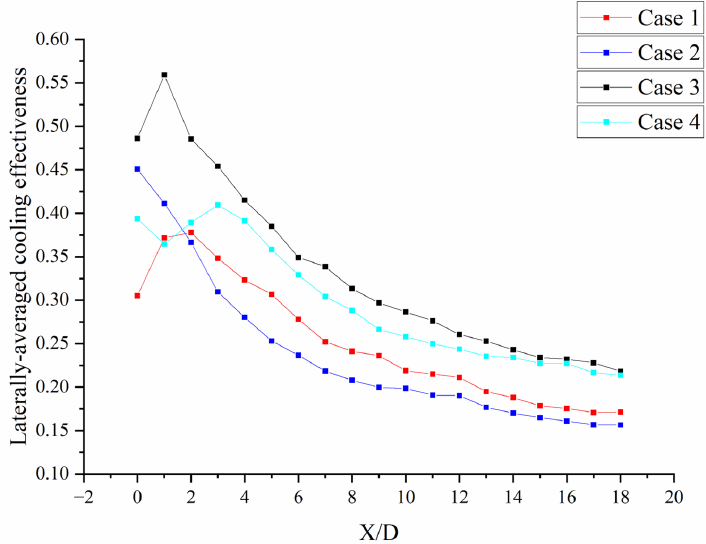
Figure 7. Distributions of laterally averaged cooling effectiveness profiles.